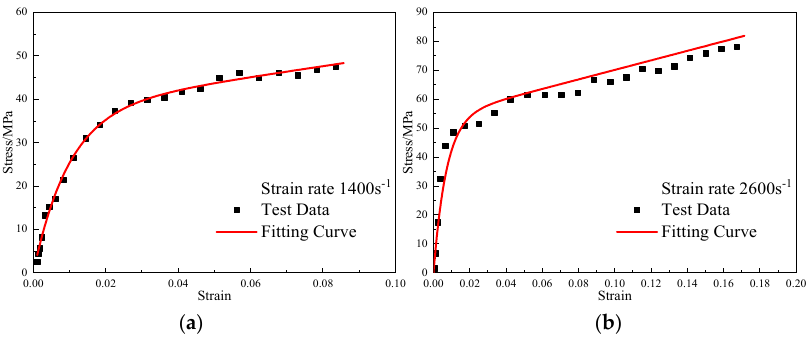
Figure 15. Comparison of the fitting results of the ZWT constitutive model with the experimental results under 600 MPa pressing pressure and at different strain rates: ( a ) 1400 s − 1 ; ( b ) 2600 s − 1 . 15 of 21 The stress–strain curves of No.15 and No.23 with different strain rates are fitted so as θ to obtain the elastic constant 2 E and relaxation time 2 , which are suitable for strain rates ranging from 1400 s − 1 to 2600 s − 1 when the pressing pressure is 800 MPa. The fitting results are shown in Figure 16. The correlation coefficients 2 R of curve fitting are 0.98 results are shown in Figure 16. The correlation coefficients R 2 of curve fitting are 0.98 and θ 0.99, respectively. The fitting results are E 2 = 6.3 GPa and θ 2 = 2.71 µ s. and 0.99, respectively. The fitting results are 2 E = 6.3 GPa and 2 = 2.71 μ s.